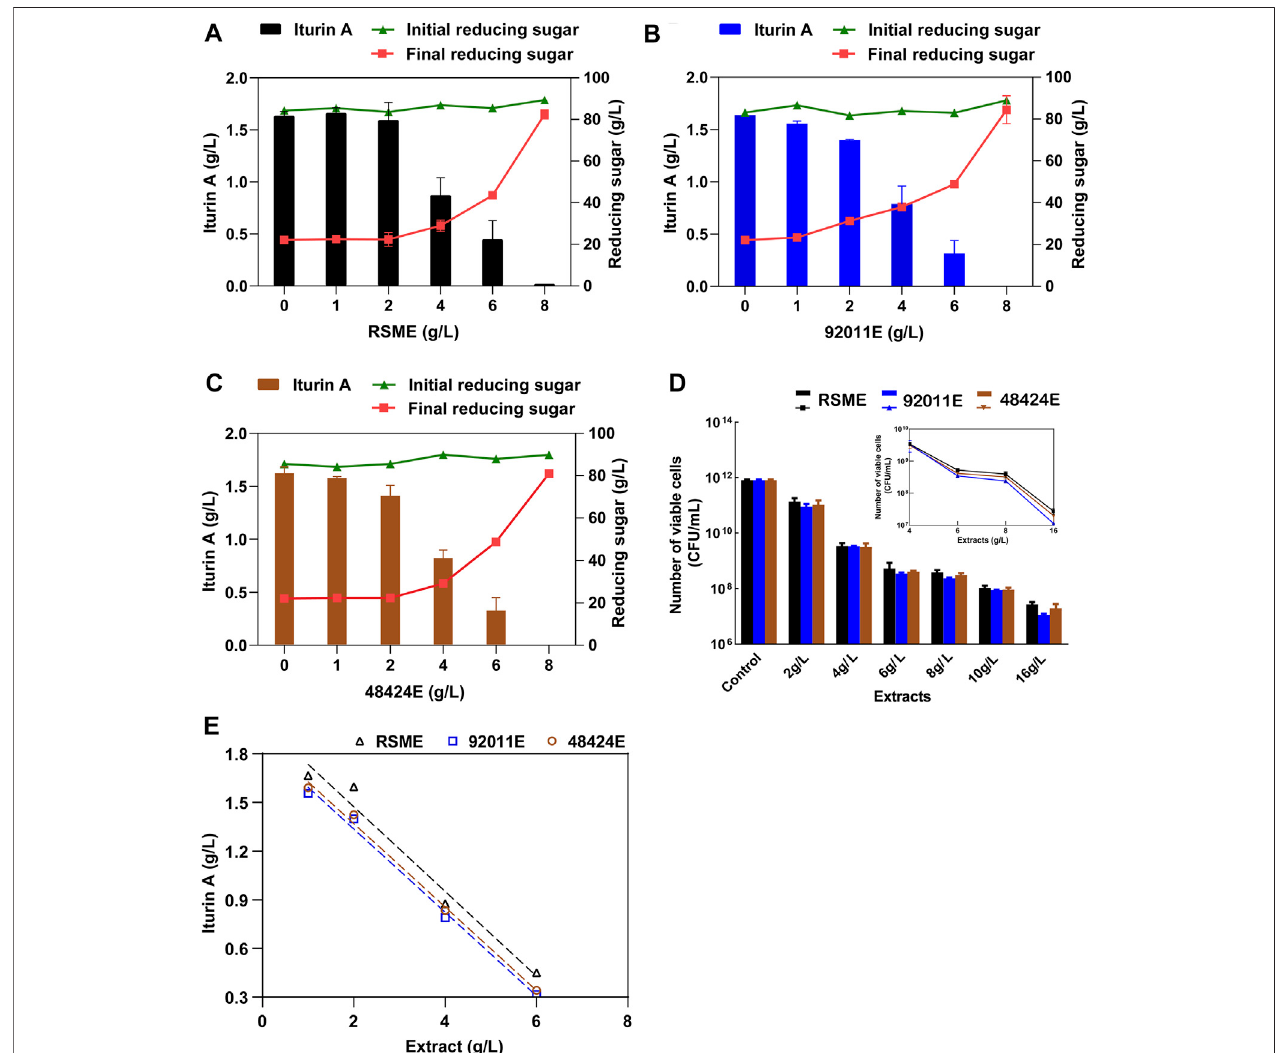
FIGURE3| InhibitoreffectsofphenolicextractsfromRSMoniturinAproductionby B.amyloliquefaciens . (A) EffectsofdifferentconcentrationsofRSMEoniturinA production, concentrations of initial and fi nal reducing sugars. (B) Effects of different concentrations of 92011E on iturin A production, concentrations of initial and fi nal reducing sugars. (C) Effects of different concentrations of 48424E on iturin A production, concentrations of initial and fi nal reducing sugars. (D) Effects of different concentrations of three phenolic extracts on the maximum number of viable cells of B. amyloliquefaciens CX-20. (E) The negative linear relationships between the iturin A production and additive amount of RSME, 92011E and